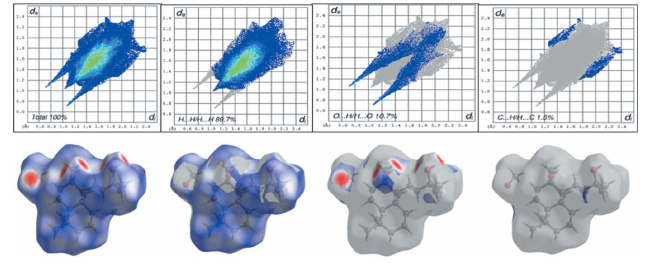
Figure 5 Two-dimensional Hirshfeld fingerprint plots for 1